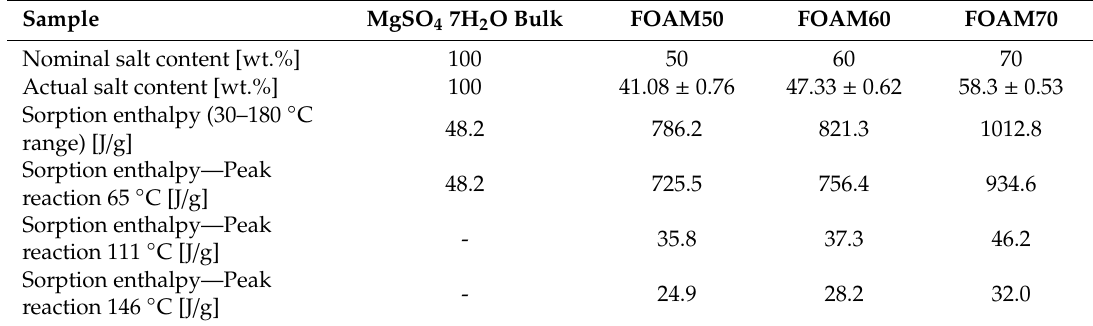
Table 1. Obtained sorption enthalpy for the tested materials in the TG / DSC